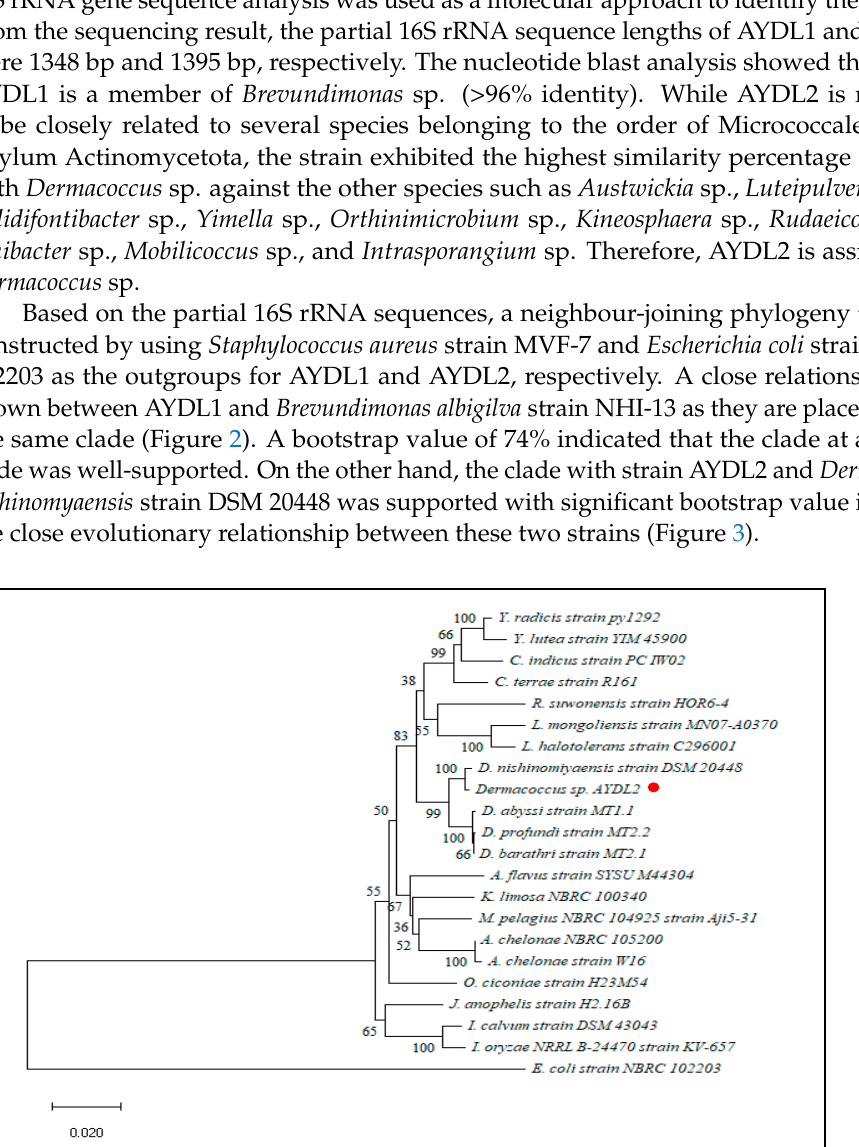
Figure 3. Phylogenetic tree of partial 16S rRNA gene sequences using the neighbour-joining method for AYDL2 ( ● ). (GenBank: OQ135212). 3.3. Assay of Polystyrene (PS) Microplastics Utilisation by AYDL1 The genus Brevundimonas is commonly attributed as a hydrocarbon degrader that has been shown to utilise compounds such as n -alkanes, polycyclic aromatic hydrocarbons (PAH) [30], diesel oil [31], and PS [32]. Moreover, Brevundimonas sp. was also found in the hydrocarbon-contaminated soils from Ross Island, Antarctica [33]. These findings corrob- orate the ability of the psychotrophic Brevundimonas sp. to be a good candidate for PS microplastics utilisation. To further understand the PS microplastics utilisation by the Antarctic bacteria, Bre- vundimonas sp. strain AYDL1 was selected for the assay of PS microplastics utilisation be- cause it exhibited a better activity in terms of the PS microplastics weight loss percentage during the preliminary screening (Table 1). The assay on PS microplastics utilisation